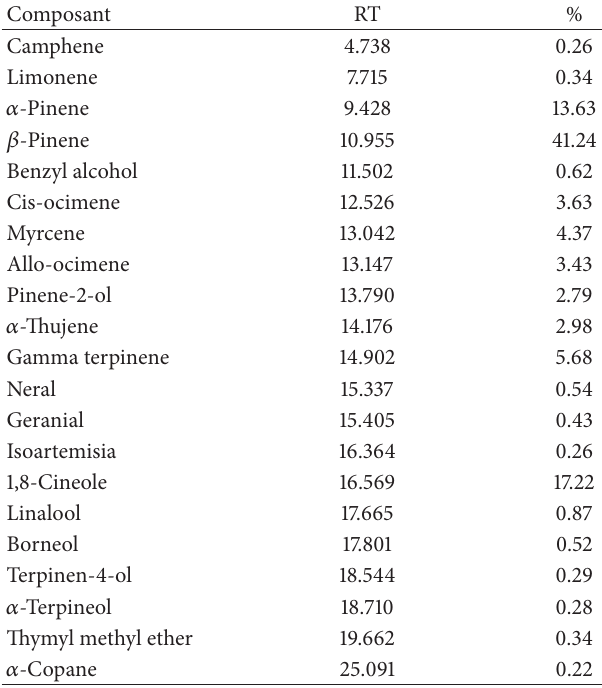
Figure 6: Angiotensin-I converting enzyme (ACE) inhibitory activity of essential oils from black pepper. Values represent means ± standard deviation of triplicate readings. Table 2: Chemical composition of essential oils from black